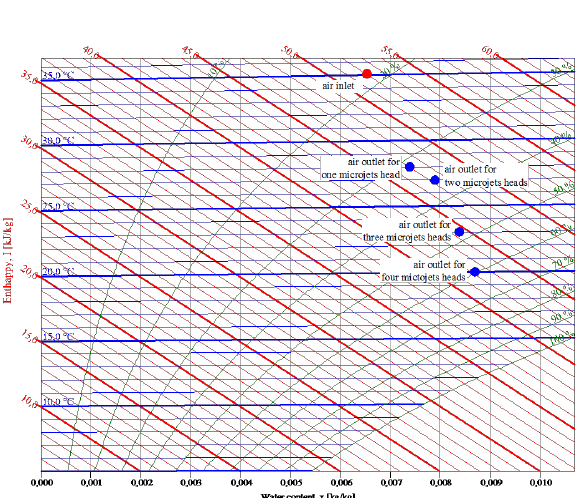
Figure 10: Air parameters during the air purification